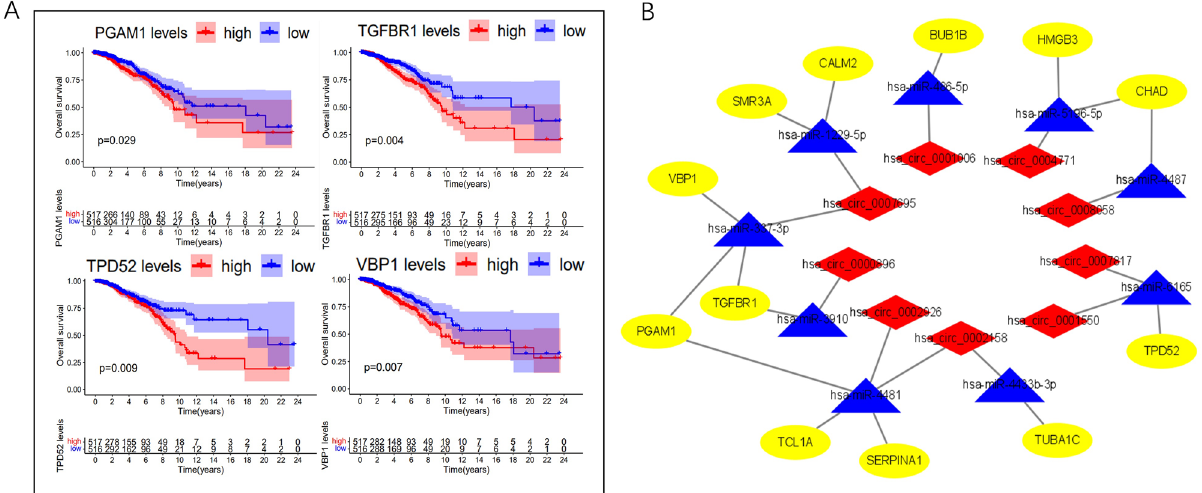
Figure 7. TCGA database was used to analyse survival prognosis on the 72 mRNAs in the ceRNA network. ( A ) The PAAM1, TGFBR1, TPD52 and VBP1 gene high expression groups in breast cancer samples had worse prognosis (P < 0.05). ( B ) Construction of prognostic ceRNA subnetwork with these survival-associated